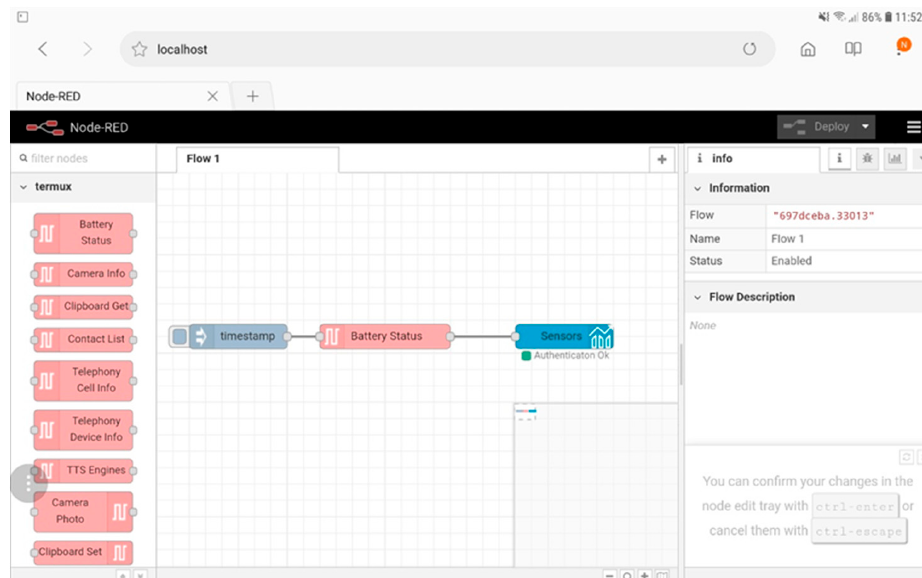
Figure 4. A flow that runs within the tablet and allows reading data from available sensors to send it to a private dashboard on the cloud. In the case of the Android tablet, it is possible to retrieve information through the sensors inside the phone, such as accelerometer, GPS antenna, gyroscope, WiFi antenna, battery sensor, etc.